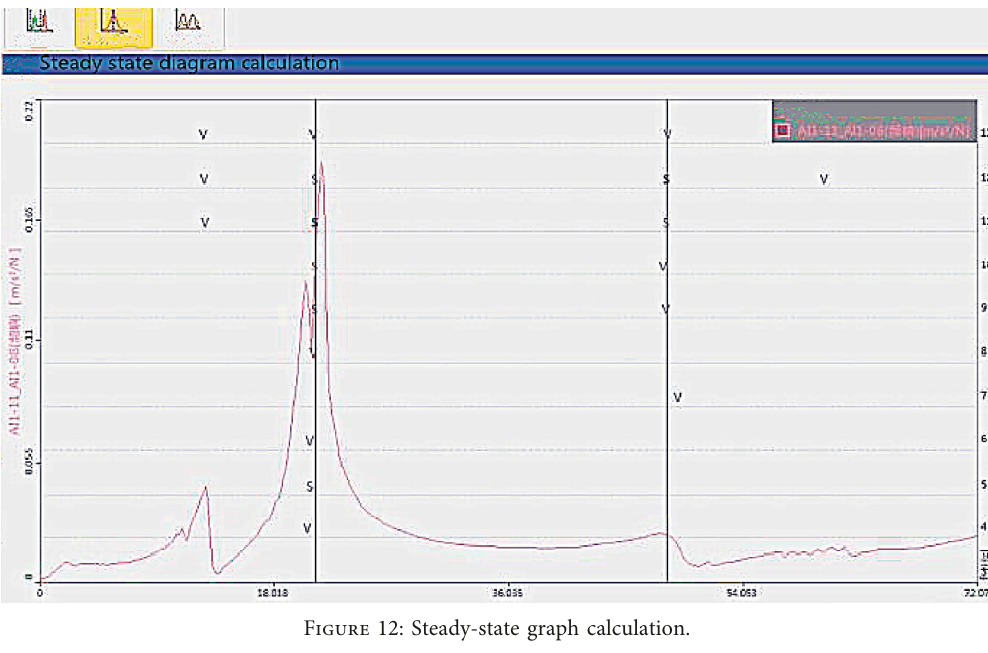
Figure 12: Steady-state graph calculation.